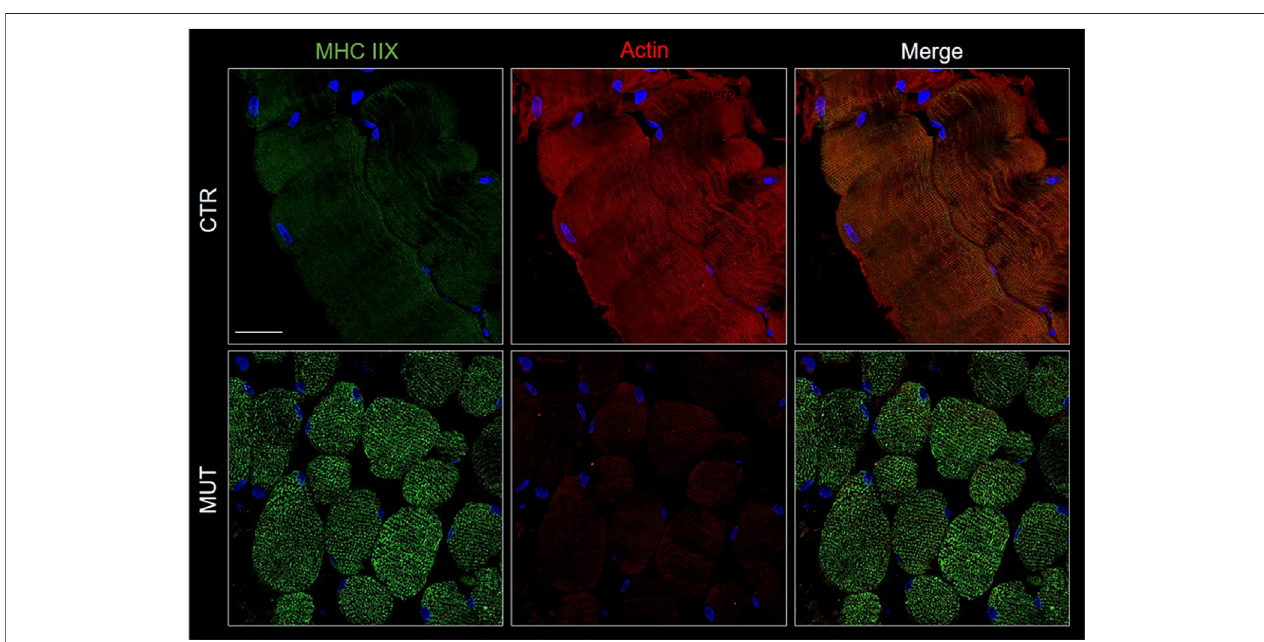
FIGURE 5 | Detection of myosin (MHC IIX) with FITC-conjugated antibody (green) and actin with TRICT-conjugated antibody (red) in CTR and MUT muscles. MyosinpositivitywashigherintheMUTthanintheCTRmusclewhereasactinpositivityshowedthereversepatternbeinghigherintheCTRmuscle.Also,thedistribution patterns of the two proteins differed in the CTR and MUT muscles and colocalization was absent. Nuclei were stained with probe Hoechst 33342 (blue). Bar = 25 µm.